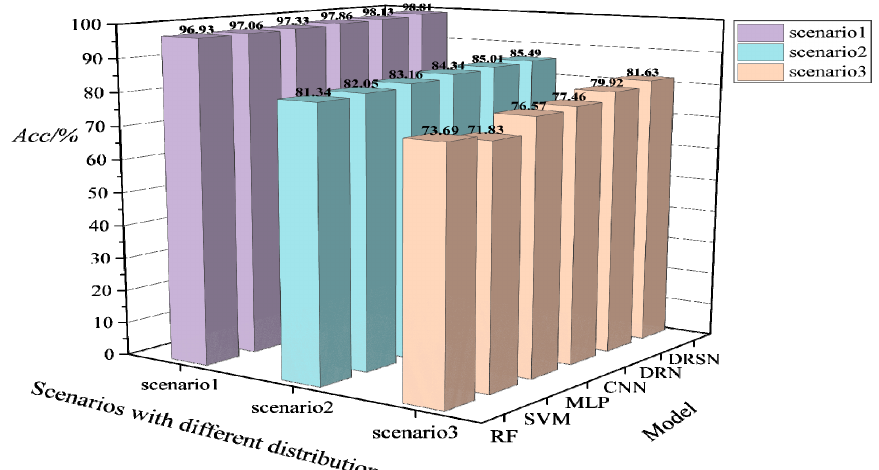
Figure 9. Acc performance of different models trained on the modified New England 39-bus system based on the fixed distribution for the new scenarios with large disturbances.